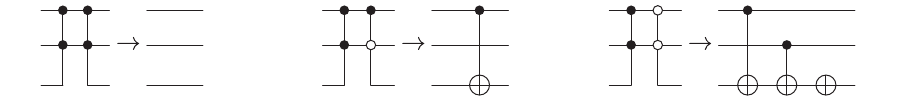
FIG. 6. When two AND operations are adjacent, the uncomputation-and-recomputation can be replaced by CNOT and NOT operations. Each such merger saves 4 T gates.